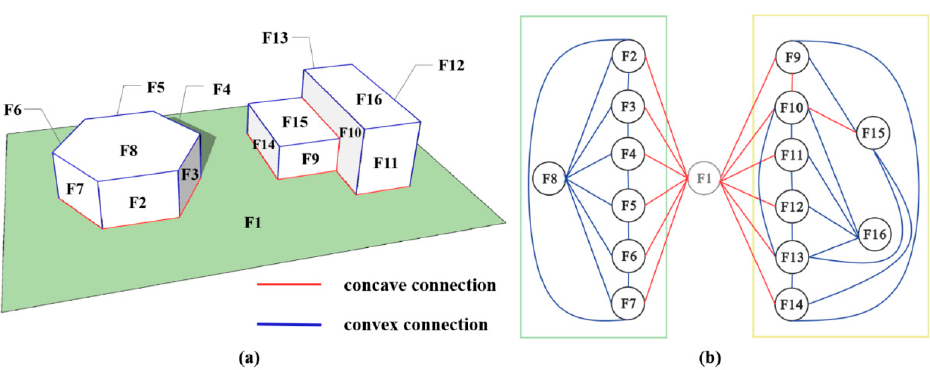
Figure 5. Extract structure from AAG: ( a ) Attached structure. The hexagonal prism on the left is a simple attached structure, and the one on the right is a complex attached structure. ( b ) AAG: The green frame corresponds to the simple attached structure. The yellow frame corresponds to the complex attached structure.